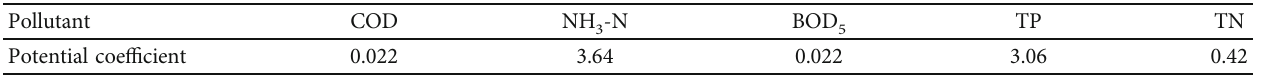
Table 26: EP pollutant and potential coe ffi